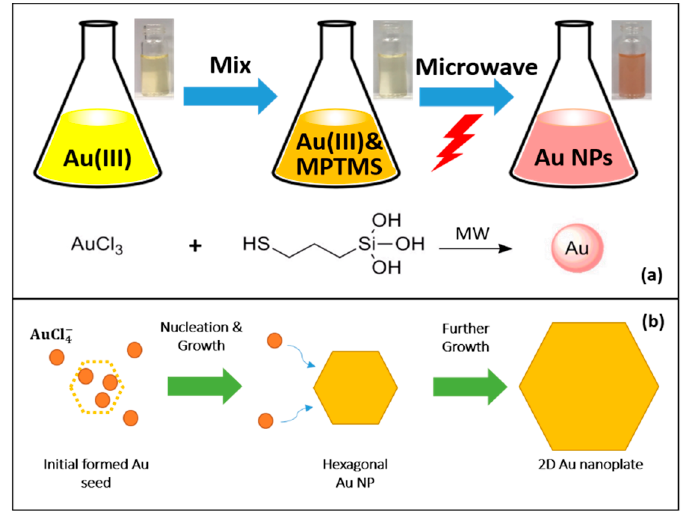
Figure 1. ( a ) Chemical procedure for synthesis of hexagonal gold nanoparticles (Au NPs). ( b ) Schematics of Au NPs growth and formation.